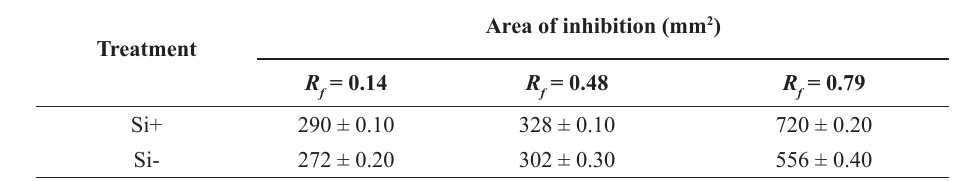
Table 1: Areas of inhibition in antifungal assay with Cladosporium cladosporioides of Silica treated (Si+) and control (Si-) extracts.